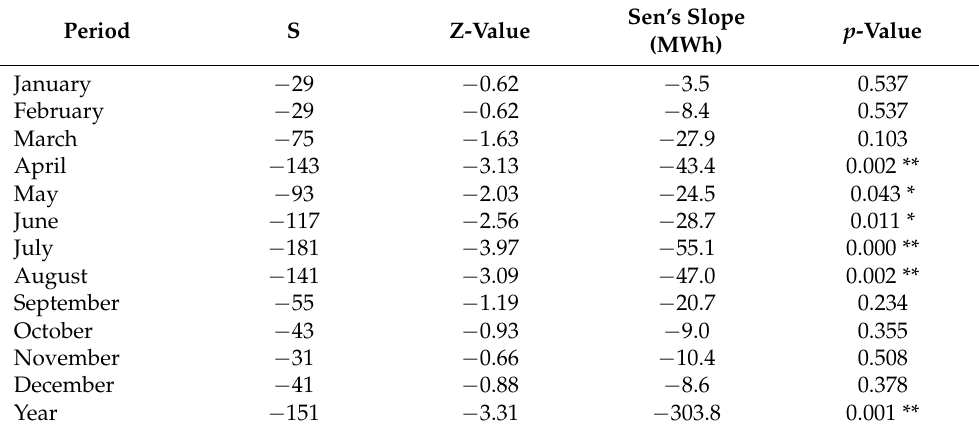
Figure 3. Direction of annual changes in electricity production by the Jeziorsko hydropower plant in the period 1995–2021. Table 2. Changes in monthly and annual values of energy production by the Jeziorsko hydropower plant in the period